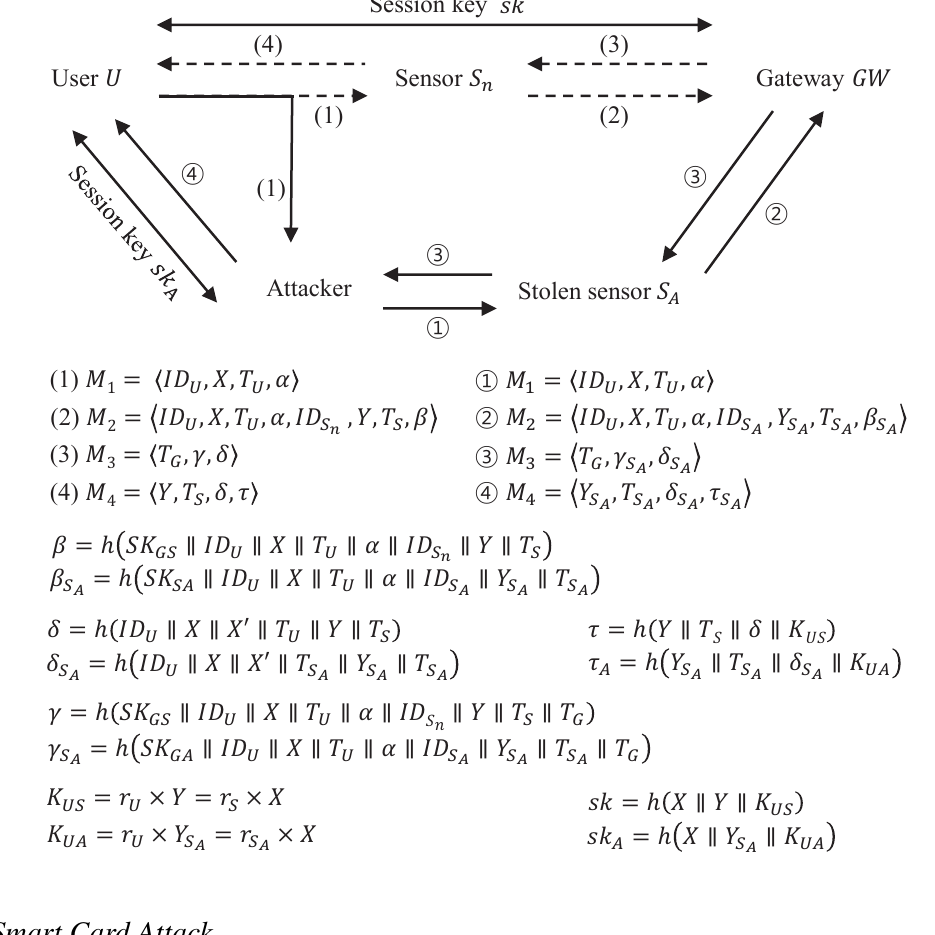
Figure 4. A session key attack on Shi et al .’s